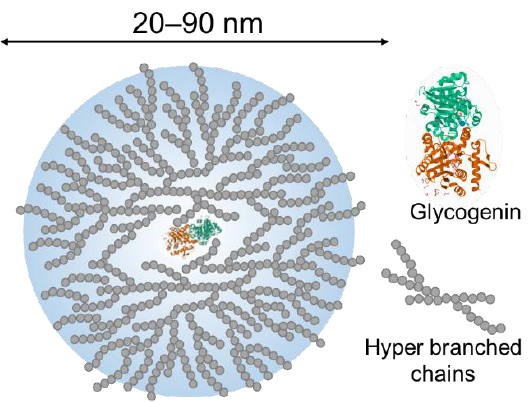
Figure 1. The structure of a glycogen nanoparticle showing the presence of glycogenin in the core and the hyper branched dendrimer-like architecture. Table 1. Physicochemical properties of glycogen a .